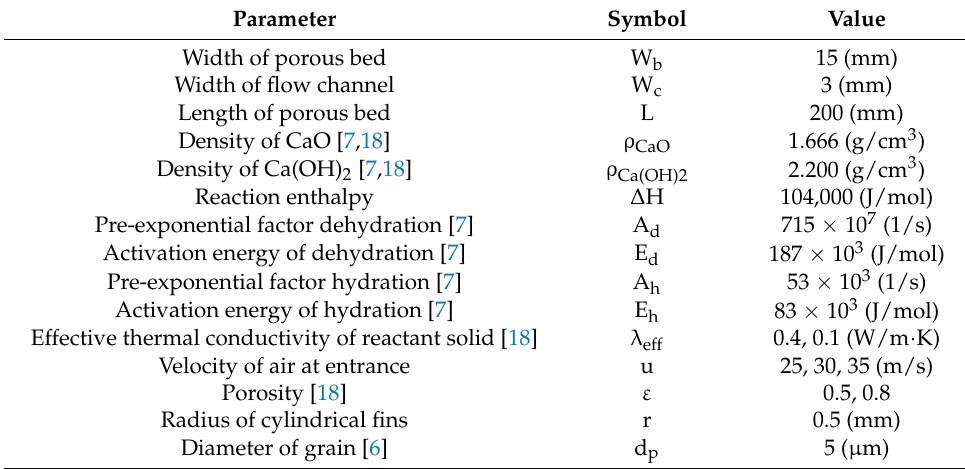
Table 1. Geometric dimensions and reaction